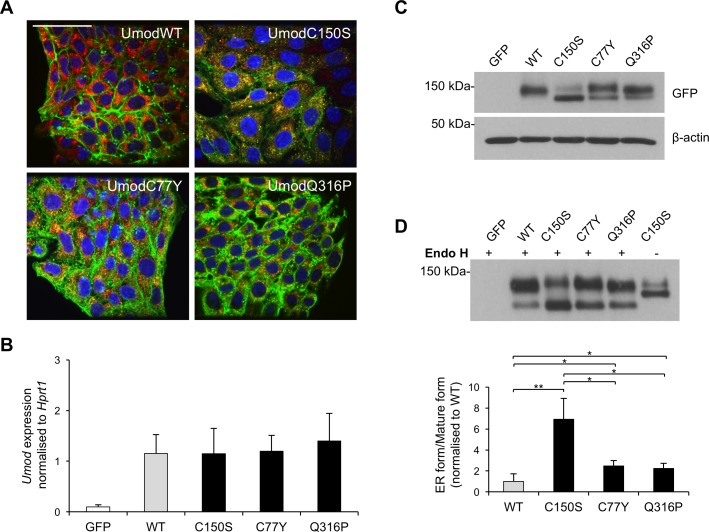
Characterisation of trafficking of different uromodulin mutants in mTAL cells.(A) Immunofluorescence analysis of mTAL cells expressing the indicated uromodulin isoforms. A merge picture of signals obtained for uromodulin (green), calreticulin (ER marker, red) and dapi (blue) is shown. Bar = 40 μm. (B) Uromodulin expression assessed by real time RT-qPCR. Expression is normalised to Hprt1. Cells expressing GFP alone are shown as negative control. (n = 6 independent experiments) (C) Western blot analysis of uromodulin expression in lysates of mTAL cells expressing the indicated uromodulin isoforms. β-actin is used as a loading control. (D) Cell lysates were deglycosylated with Endo H and analysed by Western-blot. The quantification of the ratio ER glycosylated form/mature form is shown below. *P<0.05, **P<0.01 (Student t test) (n = 4 independent experiments).